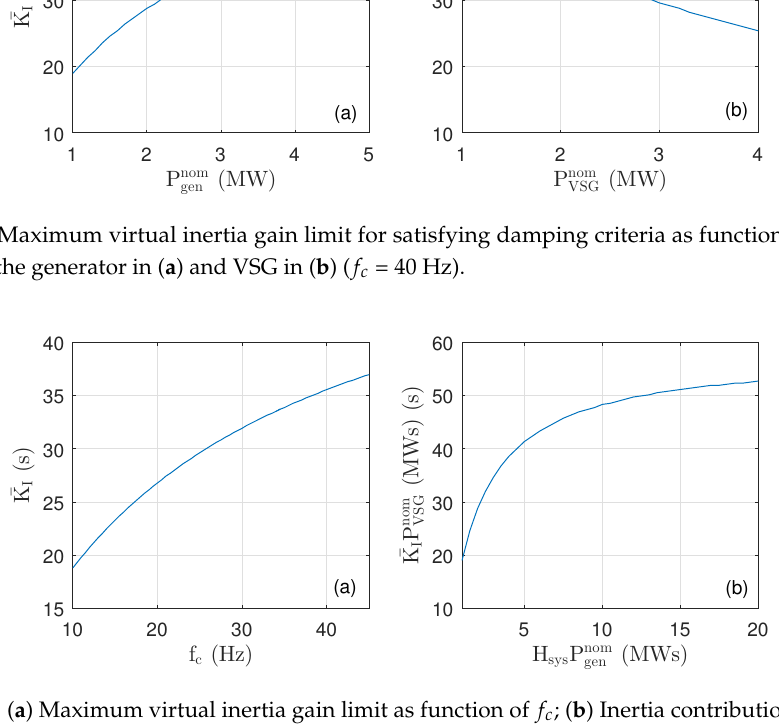
Figure 10. ( a ) Maximum virtual inertia gain limit as function of f c ; ( b ) Inertia contribution from VSG to the system in MW seconds as function of system inertia for increasing level of generator nominal power and while keeping H fixed at 5